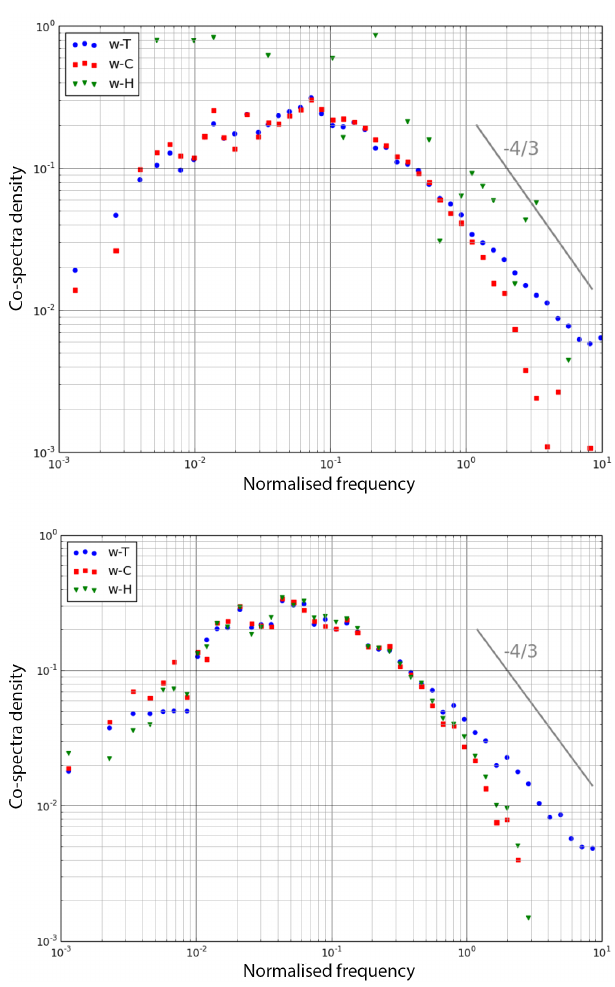
Figure 2. Co-spectra plot of vertical wind ( w ) against fluxes of car- bon ( w -C), water ( w -H) and energy ( w - T ) for Howard Springs un- derstory tower for the (a) dry season and (b) wet season. Co-spectra are grouped into 50 exponentially spaced frequency bins and repre- sent times from 1200 to 1400, which are averaged over five consec- utive days without rainfall for each season. Table 2. Records of fire activity at the Howard Springs OzFlux site from years 2012 to